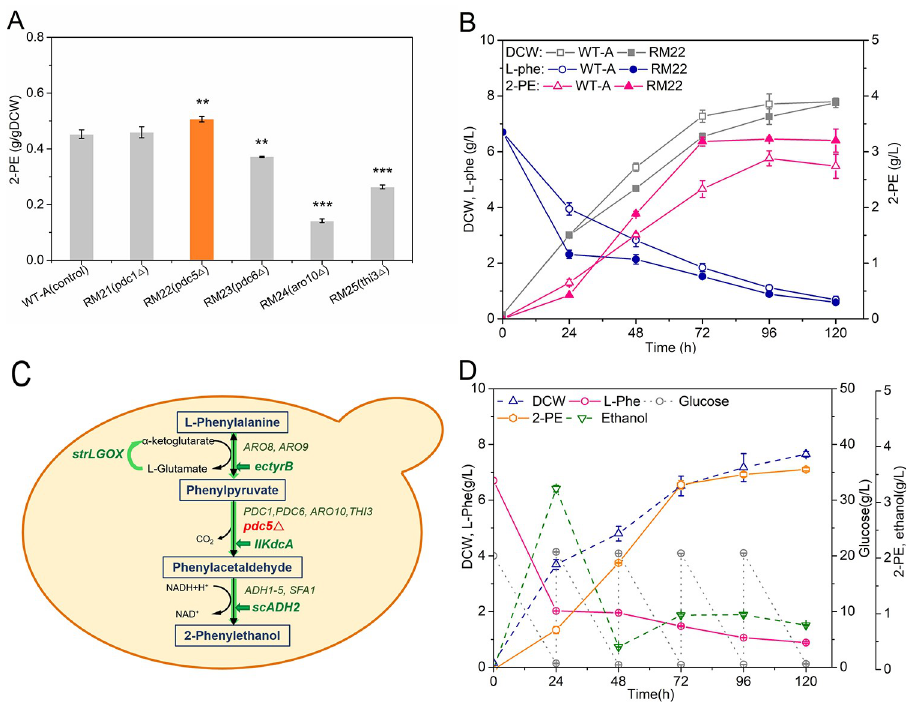
Fig 7. Impact on 2-PE synthesis in PDC5 deleting mutant. (A) Influence on 2-PE synthesis abilities of yeast cell by mutant strains RM21 (WT-A pdc1 Δ ), RM22 (WT-A pdc5 Δ ), RM23 (WT-A pdc6 Δ ), RM24 (WT-A aro10 Δ ), and RM25 (WT-A thi3 Δ ). (B) Fermentation view of RM22 (WT-A pdc5 4 ). (C) Diagram of the genetic methods in the engineered strain RM26. (D) Fermentation view of RM26 (WT-A pdc5 4 P TPI -ectyrB-llkdcA-scADH2 P TPI -strlgox) in YSM medium with the addition of 20 g/L glucose every 24 h. Data are presented as the averages of the results of three independent experiments. Error bars show standard deviations. Statistical analysis was performed by using Student’s t- test (one-tailed; two-sample unequal variance; � p < 0.05, �� p < 0.01, ��� p < 0.001).